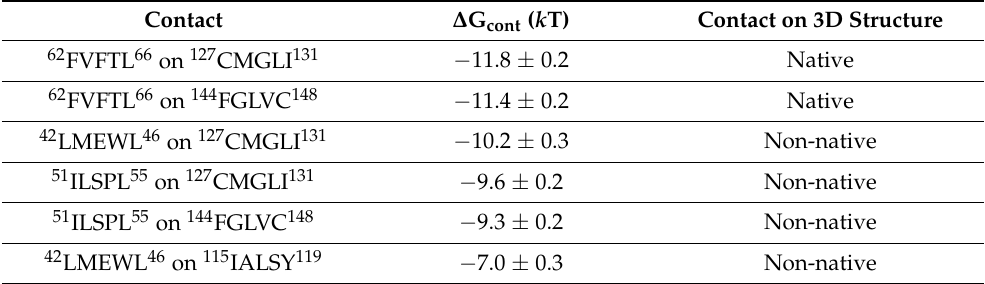
Table 2. Predicted possible primary contacts for M1. Error estimates are standard deviations [60]. The location on the structure of the defining segments was determined on PDB structure 4PUS